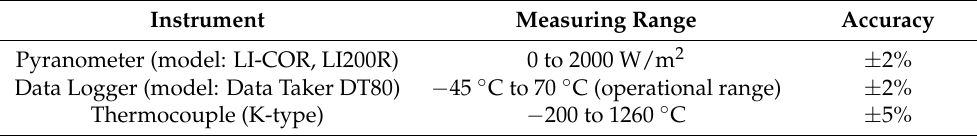
Table 1. Measurement ranges and accuracy of the instruments and